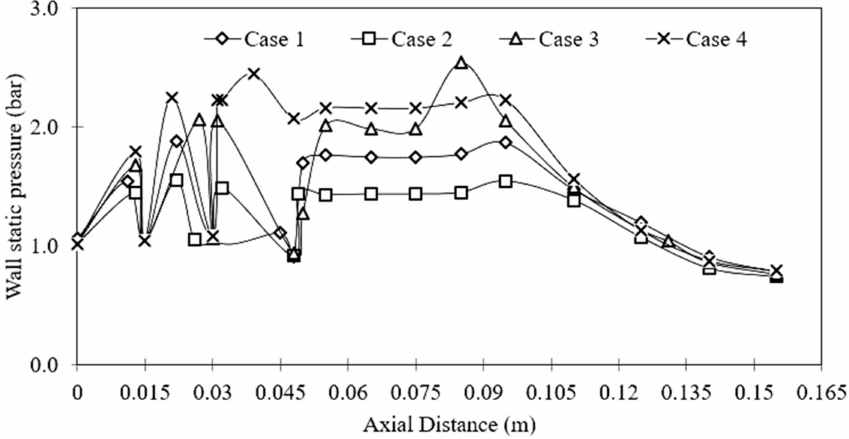
Figure 7. Different combustor geometries static pressure distribution.